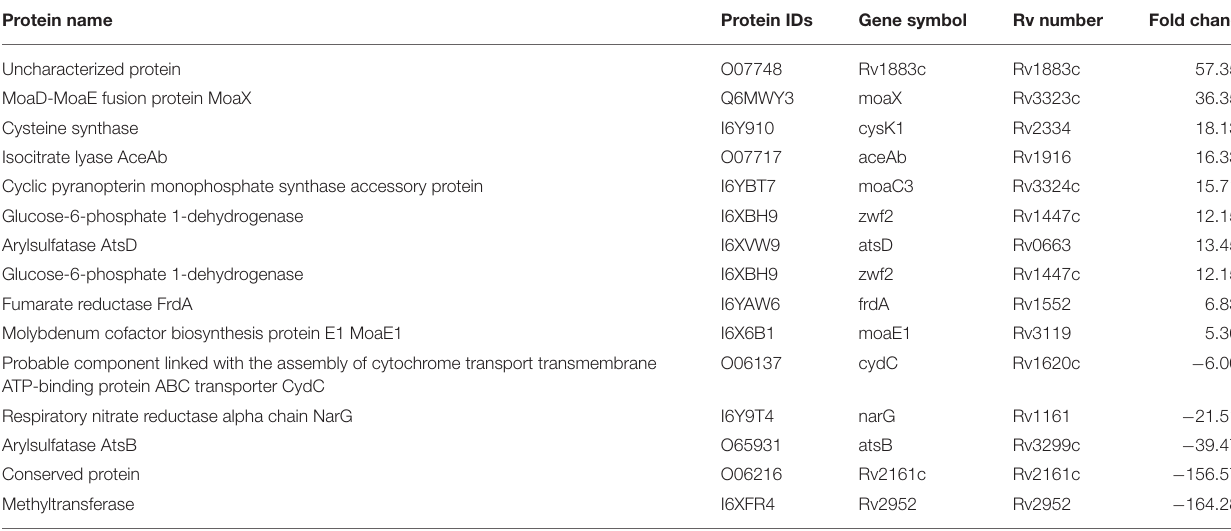
TABLE 4 | List of the differentially abundant proteins involved in ROI and RNI stress exposure responses in M. tuberculosis lineage 7 (L7-35 and L7-28) vs. lineage 4 (H37Rv) strains.